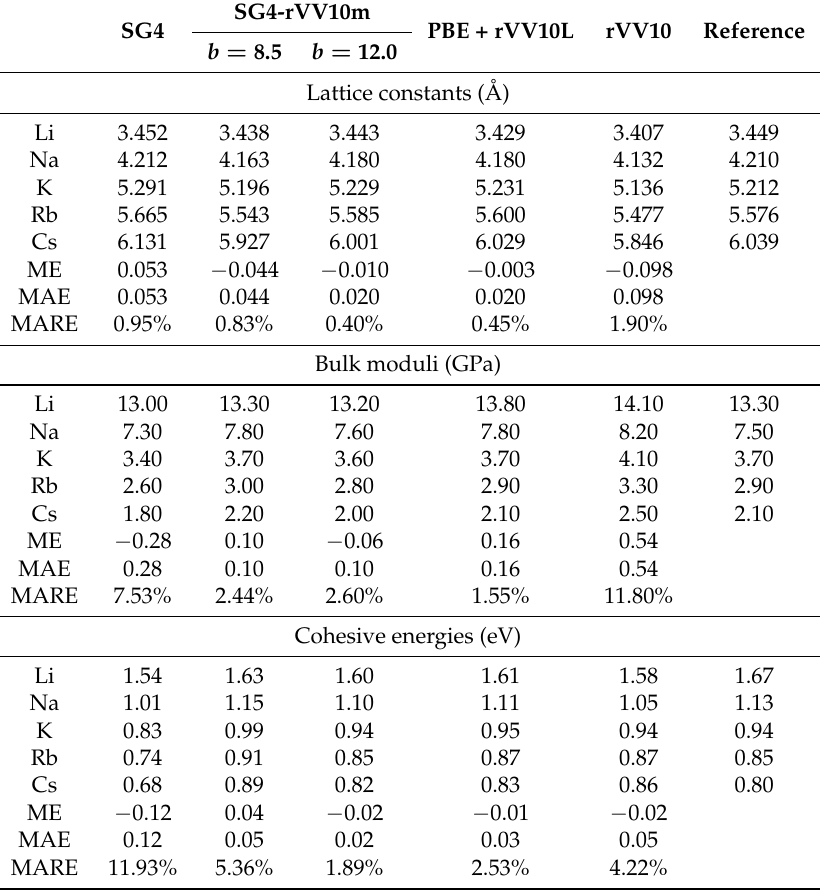
Table 2. Lattice constants, bulk moduli, and cohesive energies of the ALK5 test set as obtained with different functionals. The reference values are taken from References [64,65] and are corrected for thermal and zero-point vibrational effects. For each property, we also report the mean error (ME), the mean absolute error (MAE), and the mean absolute relative error (MARE). SG4-rVV10m SG4 PBE + rVV10L rVV10 Reference b = 8.5